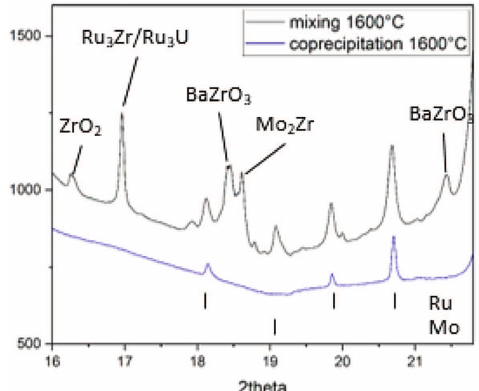
Fig. 4. Synchrotron XRD of SIMFUEL manufacture by solid (mixing) and liquid (co-precipitation)